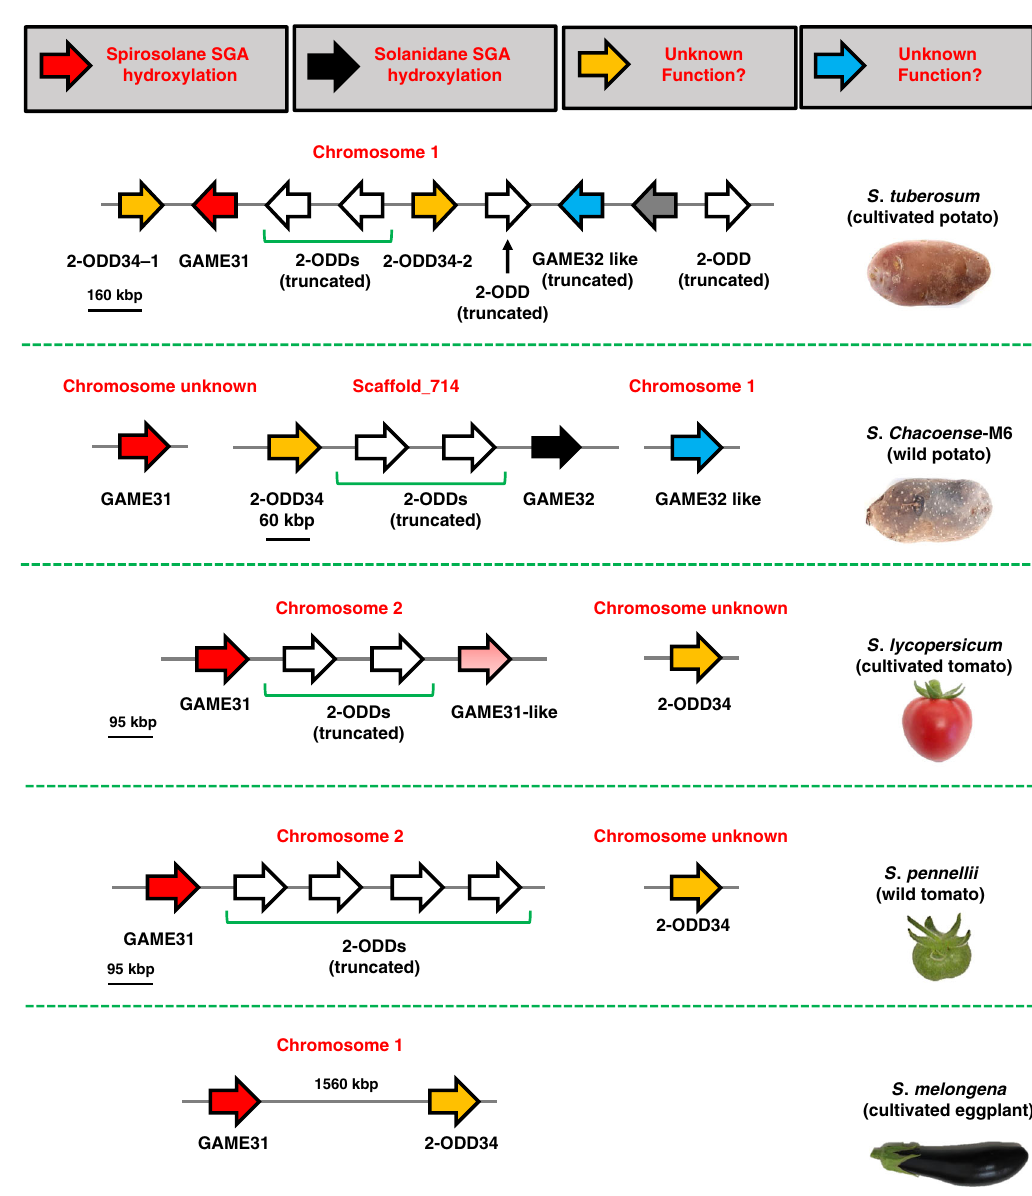
Fig. 6 Genomic organization of 2-ODD family genes in selected Solanum species associated with SGA metabolism. Four 2-ODD genes, namely, GAME31 (red block arrow), GAME32 (black block arrow), GAME32-like (blue block arrow), and 2-ODD34 (yellow block arrow), were selected for functional characterization in this study. We proposed a function for GAME31 and GAME32 genes based on in vivo and/or in vitro experiments. While GAME31 and 2-ODD34 homologs are present in all Solanum species examined, the leptinine-producing GAME32 gene appears to be unique to S. chacoense , wild potato species that possess genetic CPB pest resistance. Cultivated potato lacks the GAME32 gene, resulting in absence of leptinines and leptine SGAs, and is therefore susceptible to CPB. Truncated 2-ODDs are shown in white block arrows. The arrowheads represent direction of